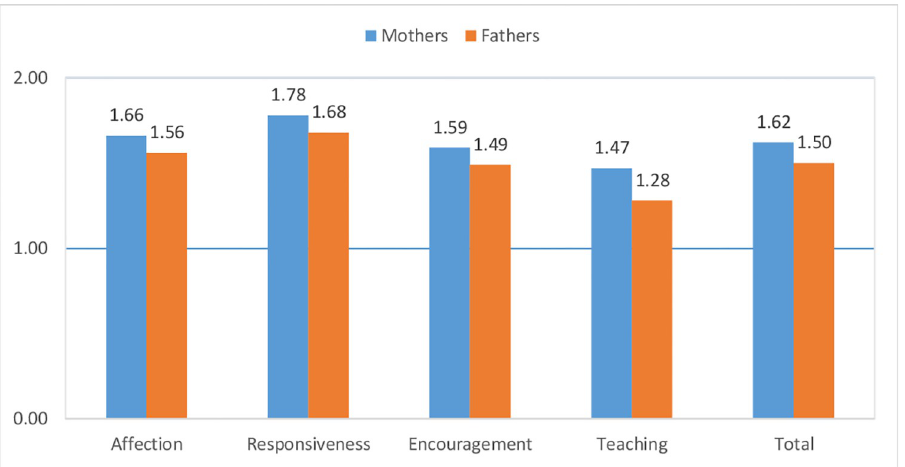
Fig 1. PICCOLO domain and total mean scores for mothers and